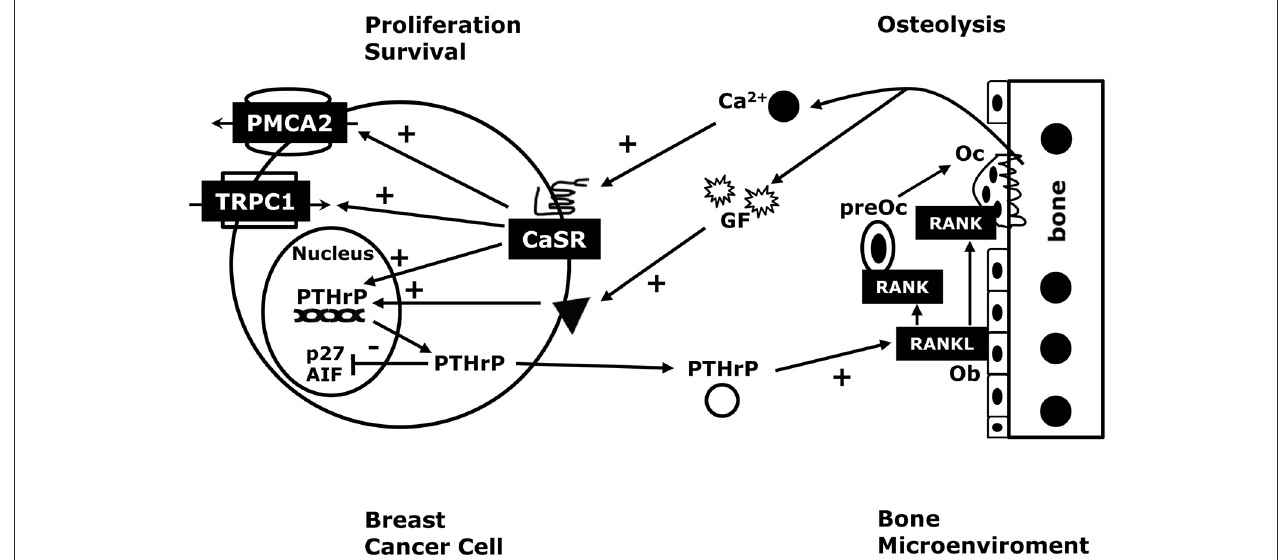
FIGURE 3 | The CaSR in breast cancer. In breast cancer cells, stimulation of the CaSR increases PTHrP production. Therefore, the high local calcium concentrations surrounding bone metastases would be expected to stimulate PTHrP secretion, which would stimulate osteoblasts (Ob) to produce more RANKL, thereby driving more osteolysis and releasing growth factors (GF) from the bone matrix that stimulate tumor cell growth. As a result, activation of the CaSR facilitates a feed-forward, vicious cycle of bone resorption, tumor growth and osteolysis. In addition, the CaSR increase the PMCA2 calcium pump activity to protect the breast cancer cells from calcium-mediated apoptosis, and regulates the TRPC1 calcium channel, which can stimulate proliferation. Finally, as outlined in Figure 2 , activation of the CaSR promotes breast cancer cell proliferation and enhances cell survival by activating a nuclear PTHrP signaling pathway that inhibits p27 kip1 and AIF respectively. These findings suggest that extracellular calcium may promote tumor cell growth by activating the CaSR, which, in turn, can activate PTHrP-dependent and PTHrP-independent signaling pathways that stimulate cancer cell proliferation, inhibit cancer cell death and promote osteoclastic bone